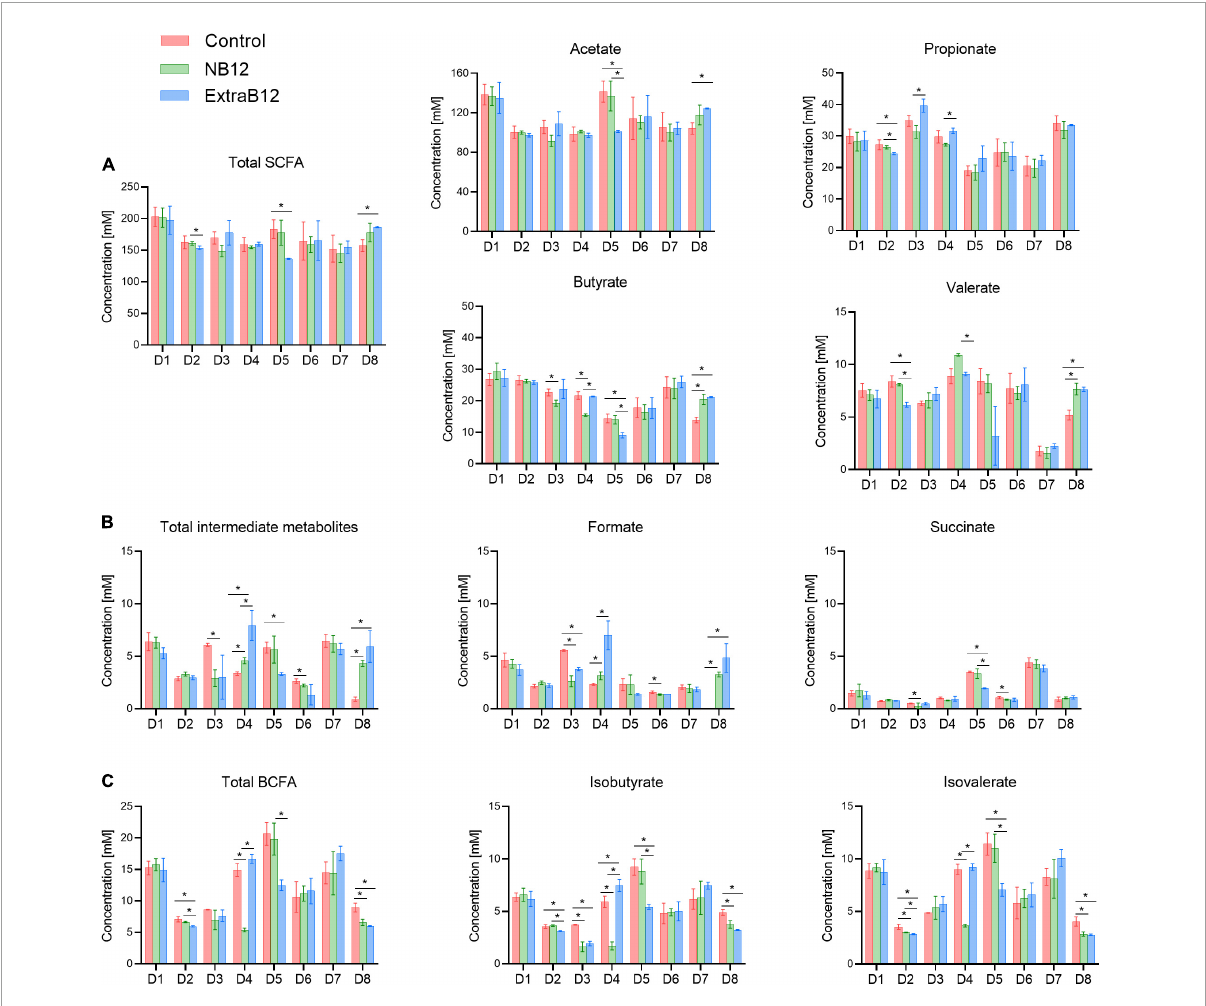
FIGURE7 Metabolite production after 24 h batch fermentation of eight fecal donor microbiota (D1 to D8) under different treatment condition (Control, NB12 and ExtraB12). (A) SCFA (acetate, propionate, butyrate and valerate); (B) BCFA (isobutyrate and isovalerate) and (C) intermediate metabolites (formate and succinate) are shown. Data are represented as average and standard deviation of three replicates. Per each measured metabolite and donor, an asterisk (*) and the bar indicate significant differences ( P < 0.05) between treatments. Lactate was below the limit of quantification (1 mM) for all